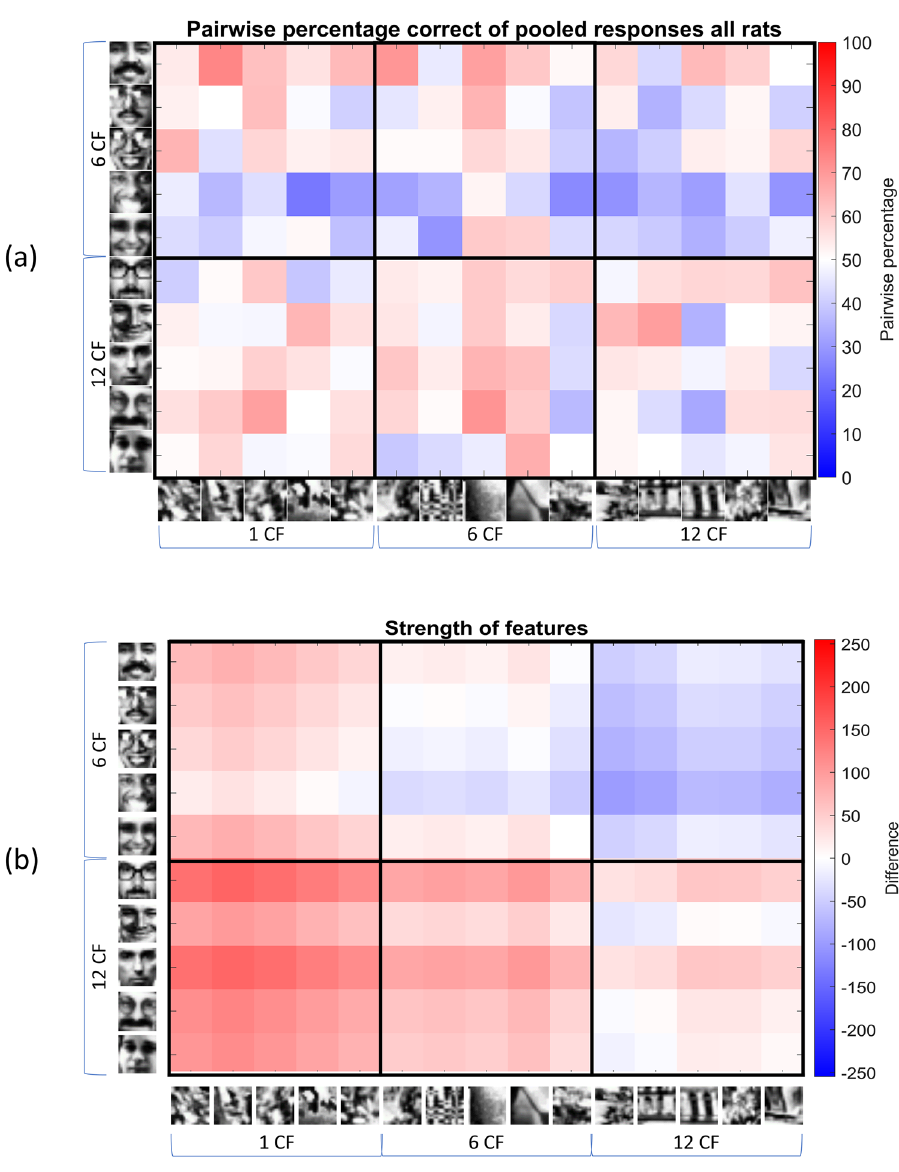
Figure 5. ( a ) Pairwise percentage correct matrix of the pooled response of all rats. The more red a cell is, the higher the performance above chance. Below chance values are indicated in blue. ( b ) The feature strength model. This model indicates how strong each feature is in each stimulus pair. The more red a cell is, the higher the average feature strength of the target, and thus the stronger the features are in the target. In both matrices, the black outlined clusters indicate the conditions as discussed in Figs. 2 and